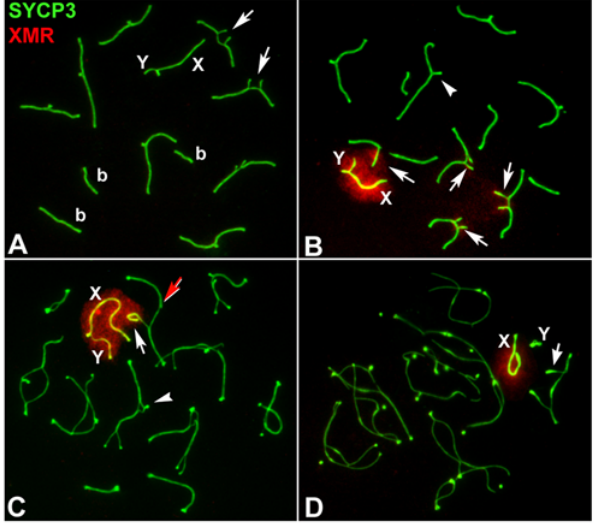
Figure 7. Localization of XMR (red) and SYCP3 (green) during prophase-I. (A) Early pachytene. XMR is not detected in both the chromatin of unsynapsed trivalents (arrows) and the XY body. (b) Bivalents. (B) Mid pachytene. XMR is present in the chromatin sex chromosomes (X, Y), while faint labeling is also detected in the unsynapsed regions of open trivalents (arrows). XMR labeling in the trivalents associated to the sex body is more intense than in those that are not associated. (C) Early diplotene. XMR persists in the unsynapsed chromatin of the trivalents (arrows) and the sex chromosomes and is not present in the segments that start desynapsis (arrowhead). Notice that a fully synapsed acrocentric in an open trivalent can elude the deposit of XMR (yellow arrow). (D) Late diplotene. XMR tends to disappear and is almost undetectable at the end of diplotene.